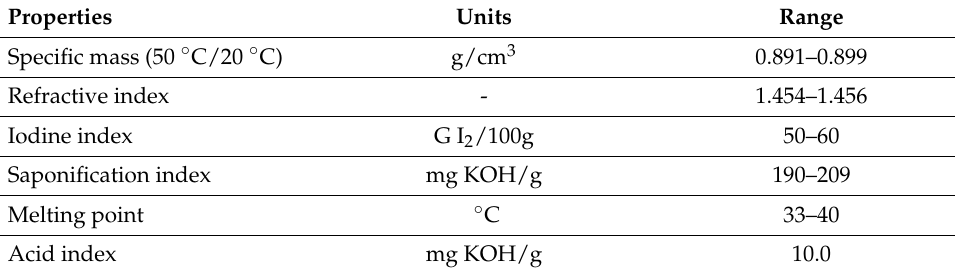
Table 3. Physicochemical properties range of crude palm oil (CPO) [31,33–35].